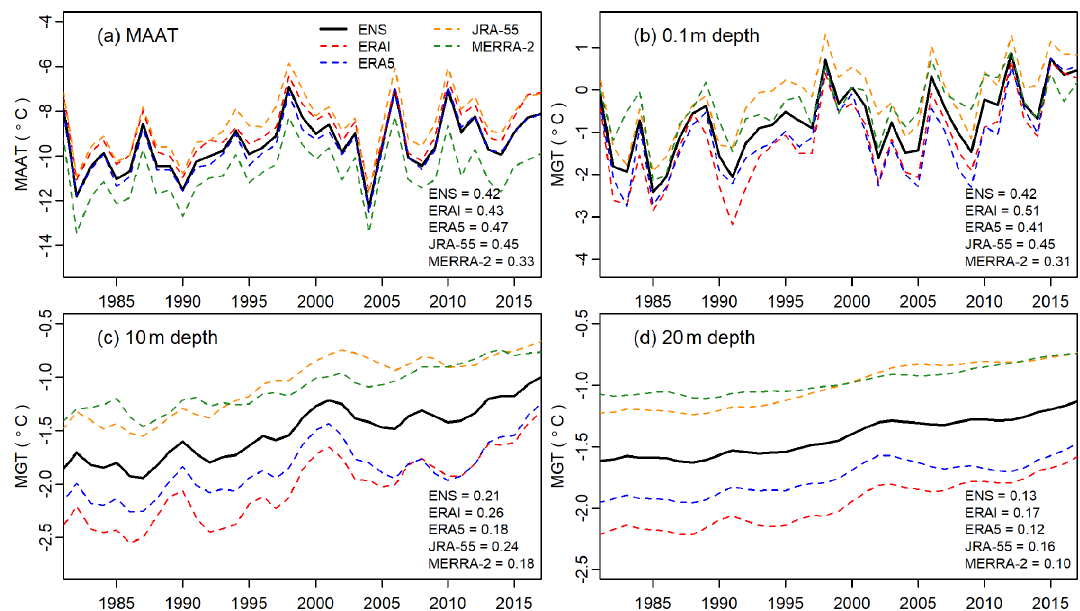
Figure 10. Changes of (a) mean annual air temperature (MAAT) derived from reanalyses, modeled annual mean ground temperature (MGT) at the depth of (b) 0.1m, (c) 10m and (d) 20m for shrubby hummocks (SH) terrain type of between 1980 and 2017. The numbers in the lower right of each figure correspond to the magnitude of the warming trend for each reanalysis and their ensemble mean with the unit of ◦ C per decade. ENS corresponds to ensemble mean. The trend lines were calculated using a linear regression model, and all the slopes were statistically significant with p < 0 .